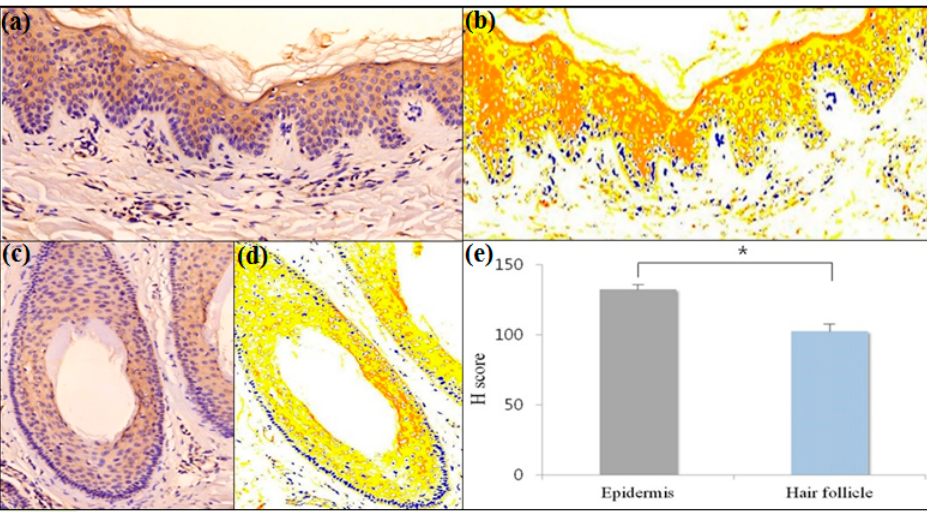
Figure 1. ( a ) Erythroid differentiation regulator 1 (Erdr1) expression in scalp epidermis of a healthy control; Immunostaining of Erdr1 is shown in brownish-red color; ( b ) HistoQuant™ measurement for the intensity of Erdr1 expression in scalp epidermis of the healthy control; Red—strong positive; orange—moderately positive; yellow—weakly positive; blue—negative nuclei; white—negative pixels in normal epidermis; ( c ) Erdr1 expression in the hair follicle of a healthy control; ( d ) HistoQuant™ measurement for the intensity of Erdr1 expression in hair follicle of the healthy control; ( e ) The intensities of Erdr1 expression in the epidermis and hair follicles of the healthy control were quantitatively evaluated with an H score using HistoQuant™; Erdr1 immunostaining, original magnification ( a – d ) ×200; * indicates a p -value less than 0.05.